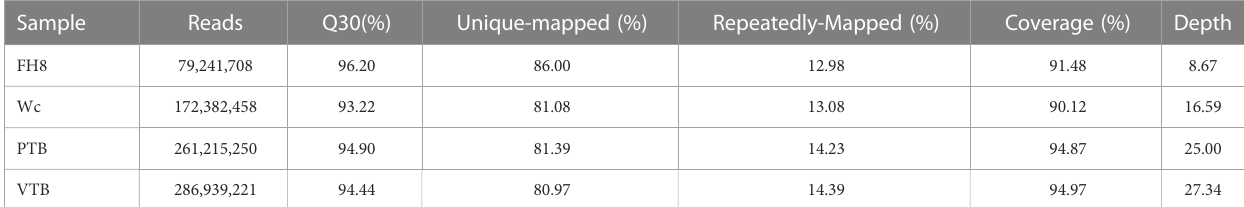
TABLE 2 Summary of sequencing